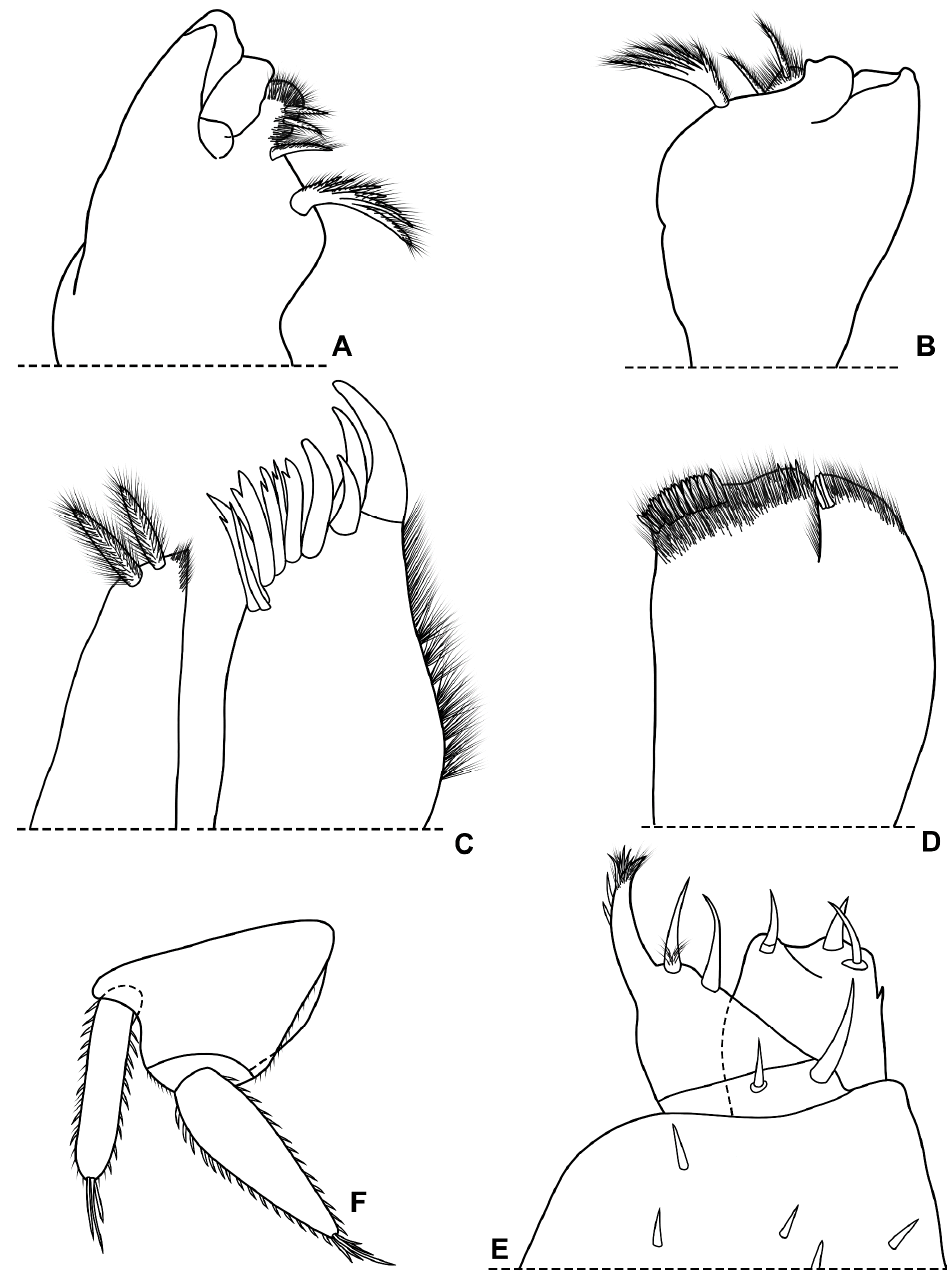
Figure 5. Sardoniscus marmoratus sp. n., paratype ♀ from Tann-a da Scaggia, Bargagli. ( A ) Left mandible. ( B ) Right mandible. ( C ) Maxillula. ( D ) Maxilla. ( E ) Maxilliped. ( F ) Right uropod.